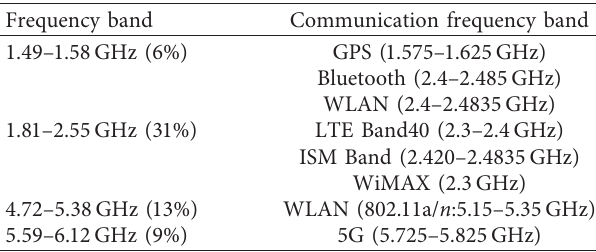
Figure 4: Comparison chart of return loss during antenna evolution.